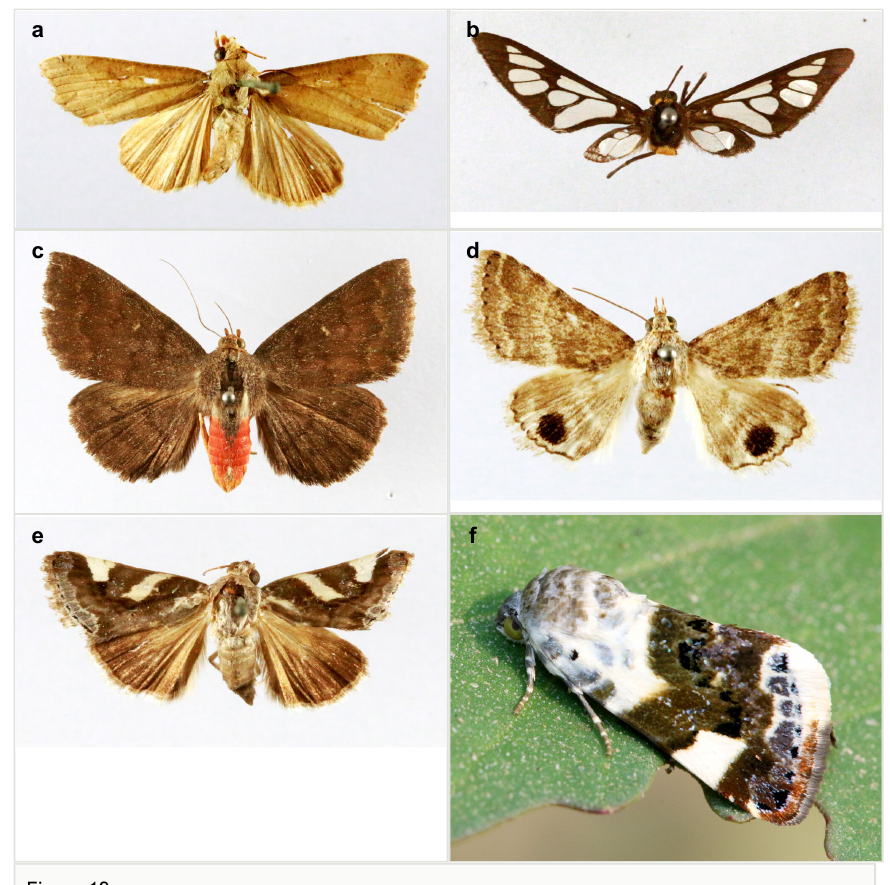
Figure 19. Adults of a. Anomis involuta ; b. Syntomoides imaon ; c. Calesia haemorrhoa ; d. Anumeta atrosignata ; e. Acontia catenula ; f. Acontia